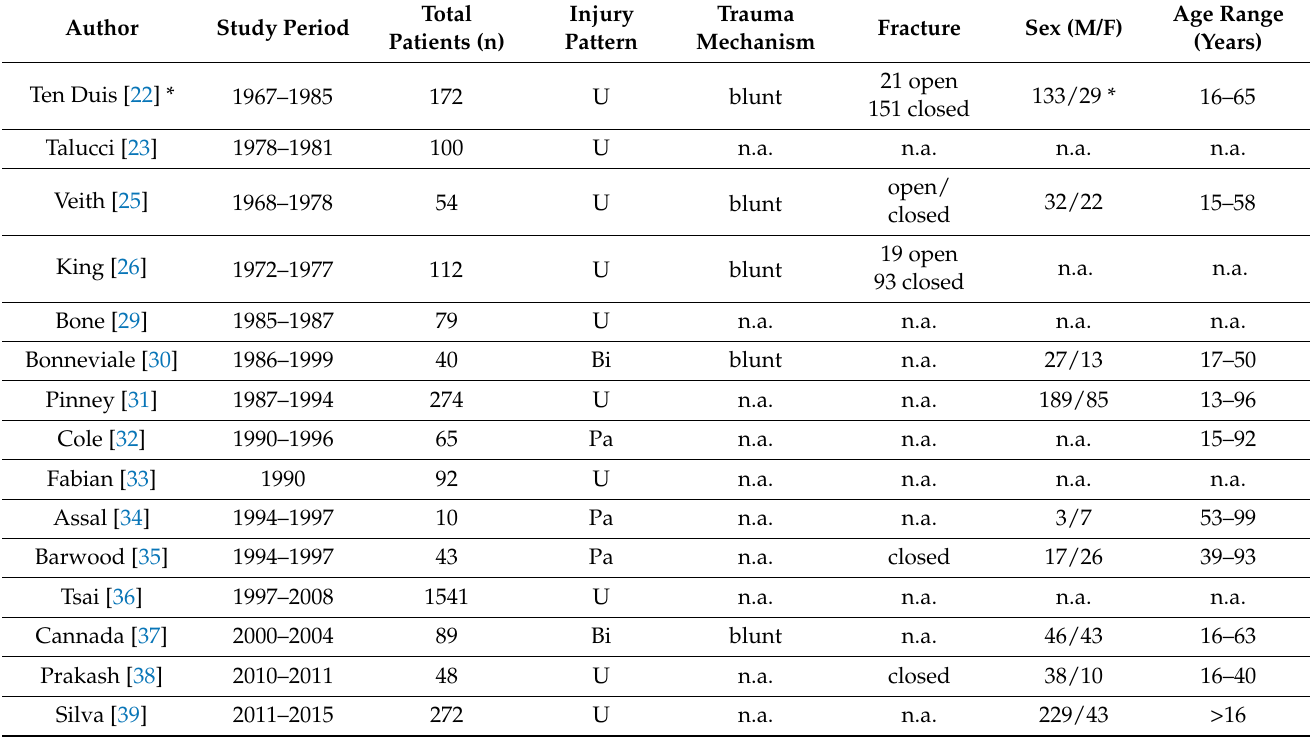
Table 2. Study populations.